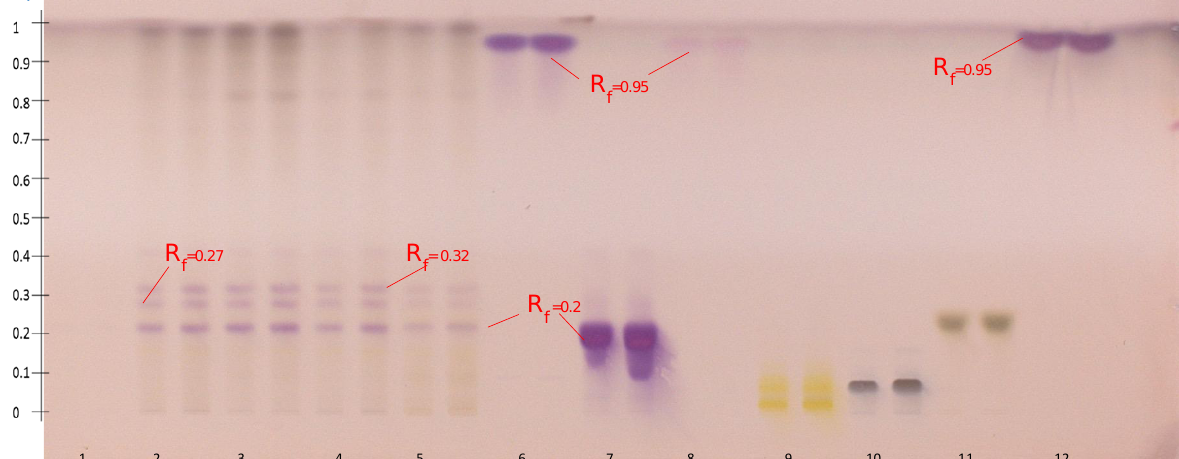
Figure 7. HPTLC profile obtained after visualization with anisaldehyde-H 2 SO 4 of the four Zaghouan extracts according to P1 (Track 2), P2 (Track 3), P3 (Track 1), and P4 (Track 4), and according to the M1 method (Track 5) as well as the standards: soyasapogenol (Track 6), soyasaponin (Track 7), senegenin (Track 8), solanine (Track 9), digitonin (Track 10), glucose–fructose (Track 11), and oleanolic acid (Track 12), according to the S2 elution system).